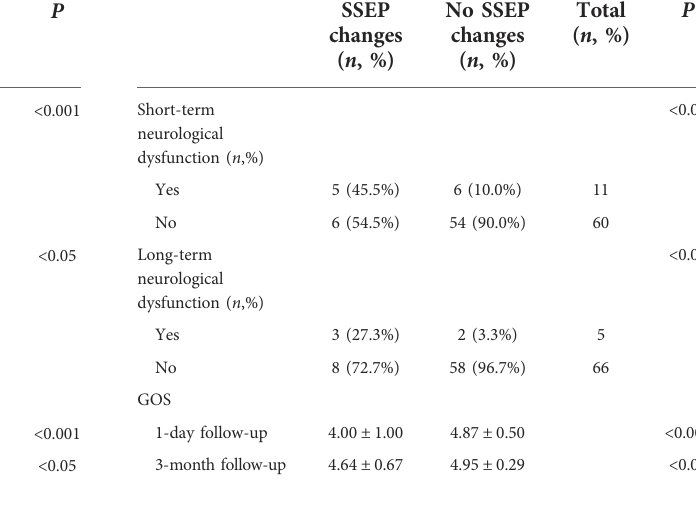
TABLE 2 Relationship between intraoperative MEP and postoperative neurological dysfunction and GOS score.